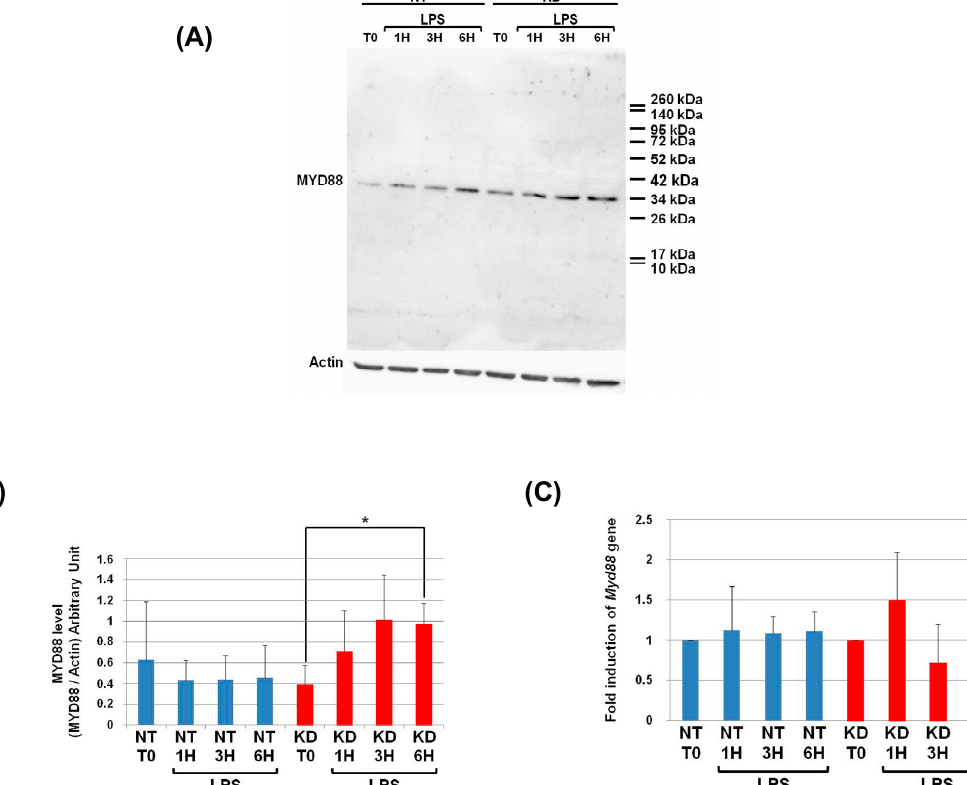
Figure 6. At 6 h post-LPS treatment, PC1 / 3 KD cells significantly exhibit higher levels of MYD88 than NT cells. ( A ) NT and PC1 / 3 KD NR8383 macrophages were treated with 200 ng / mL of LPS for 0, 1, 3, and 6 h. Western blot studies were then conducted with anti-MYD88, see Figure 4. ( B ) Intensities of MYD88’s full-length form at 33,8 KDa, quantified and normalized to those of Actin. ( C ) The modulation of Myd88 gene expression investigated in NT and PC1/3 KD NR8383 macrophages challenged with 200 ng/mL of LPS for 0, 1, 3, and 6 h. The results are obtained from three independent experiments